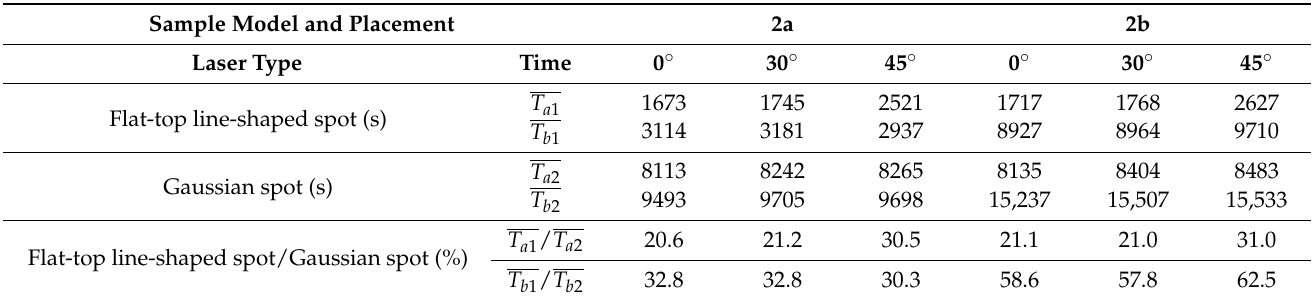
Table 9. Molding data of sample